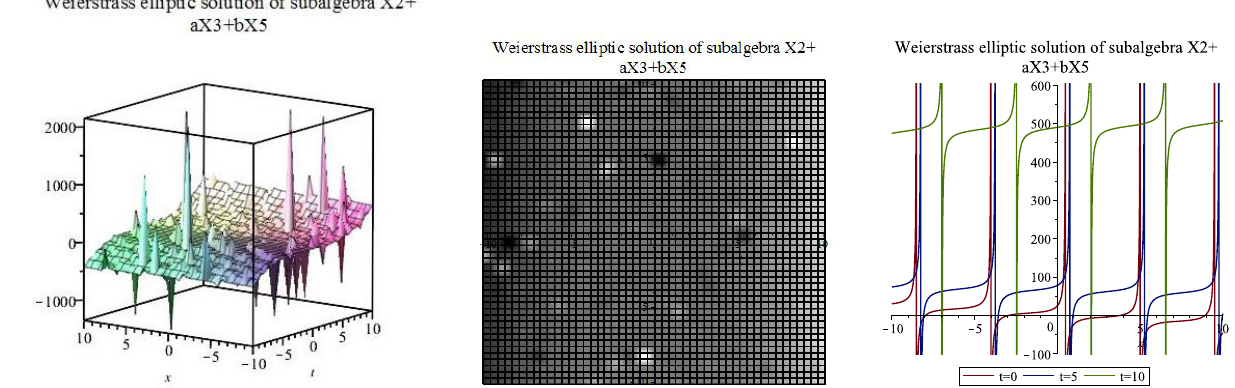
Figure 17. Solitary wave depiction of Weierstrass elliptic solution (60) at y = 1.